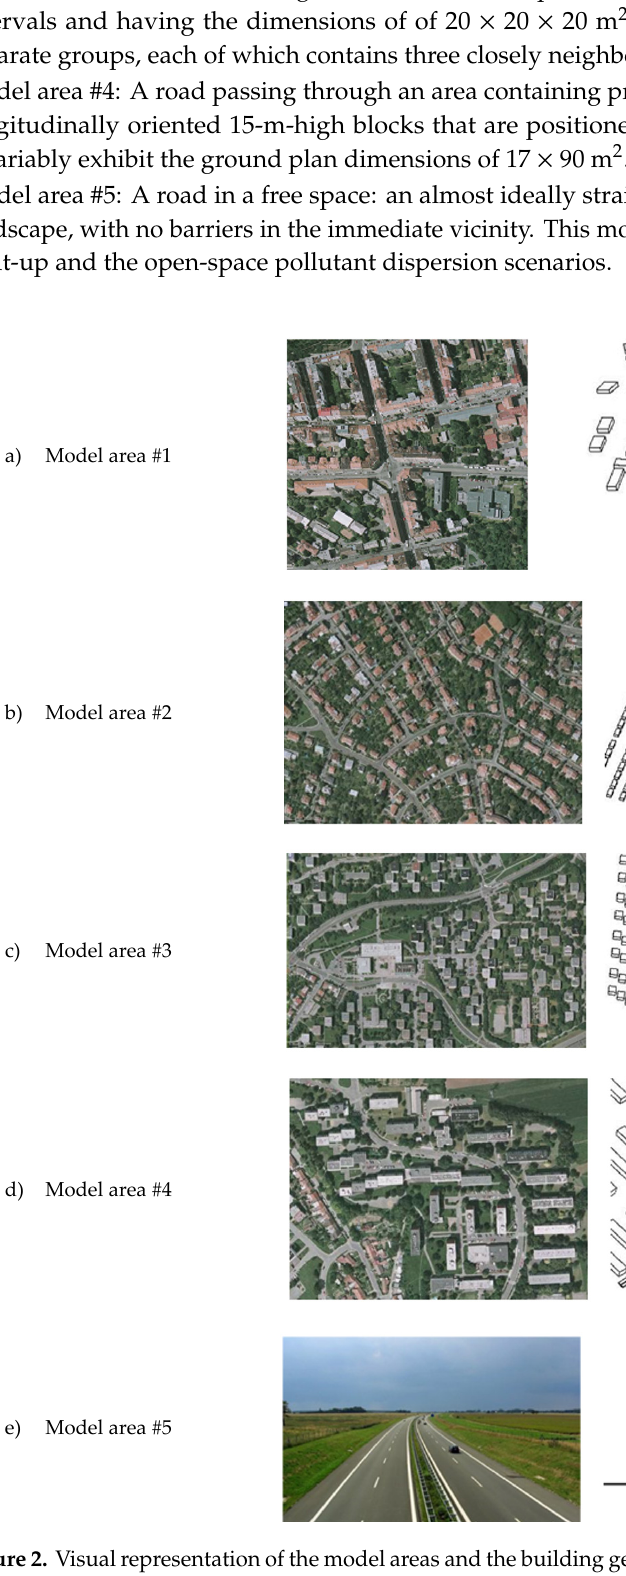
Figure 2. Visual representation of the model areas and the building geometries embodied in the relevant numerical models.